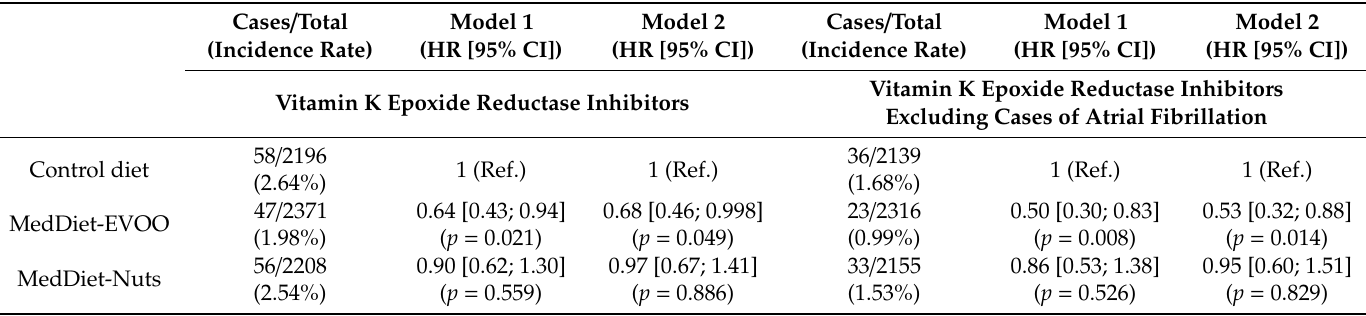
Table 2. Incidence of new users of vitamin K epoxide reductase inhibitors